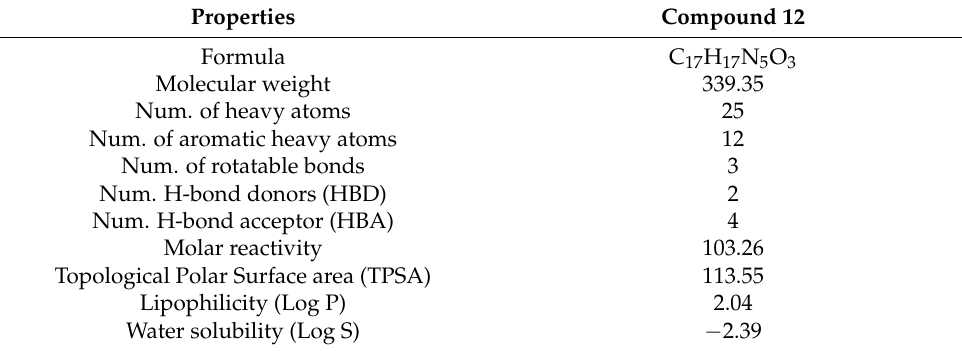
Table 4. Physiochemical properties and